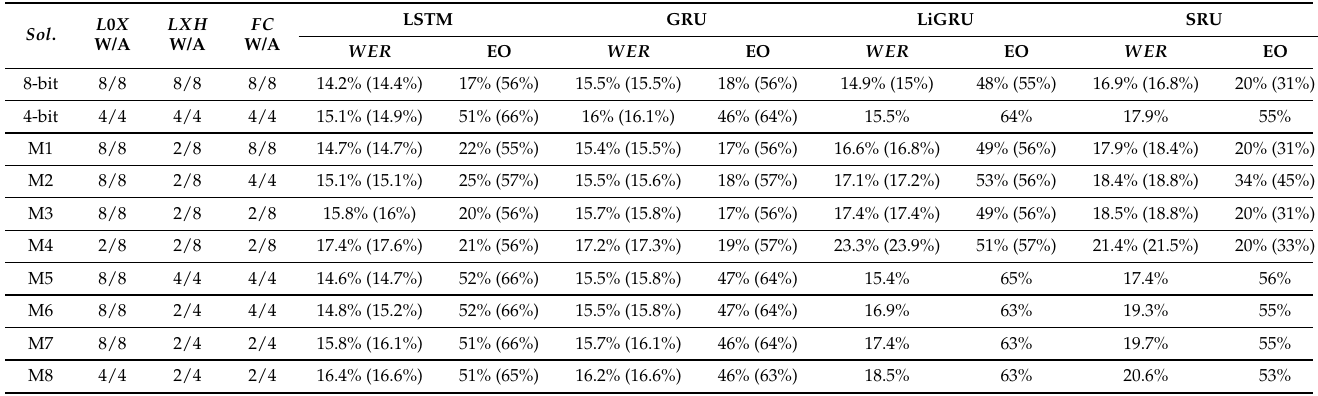
Table 3. The result of applying post-training quantization with delta networks method on the LSTM-, GRU-, LiGRU-, and SRU-based models. L 0 x is the precision of first-layer input computations, while LXH is the precision of the rest of the layers’ input and hidden state (projection is case of SRU) computations. FC is the precision of the FC layer. W / A denotes weight and activation precision. For each quantization configuration, we show the WER and EO (percentage of eliminated operations). We applied delta with thresholds higher than zero and put resultant error and EO is between